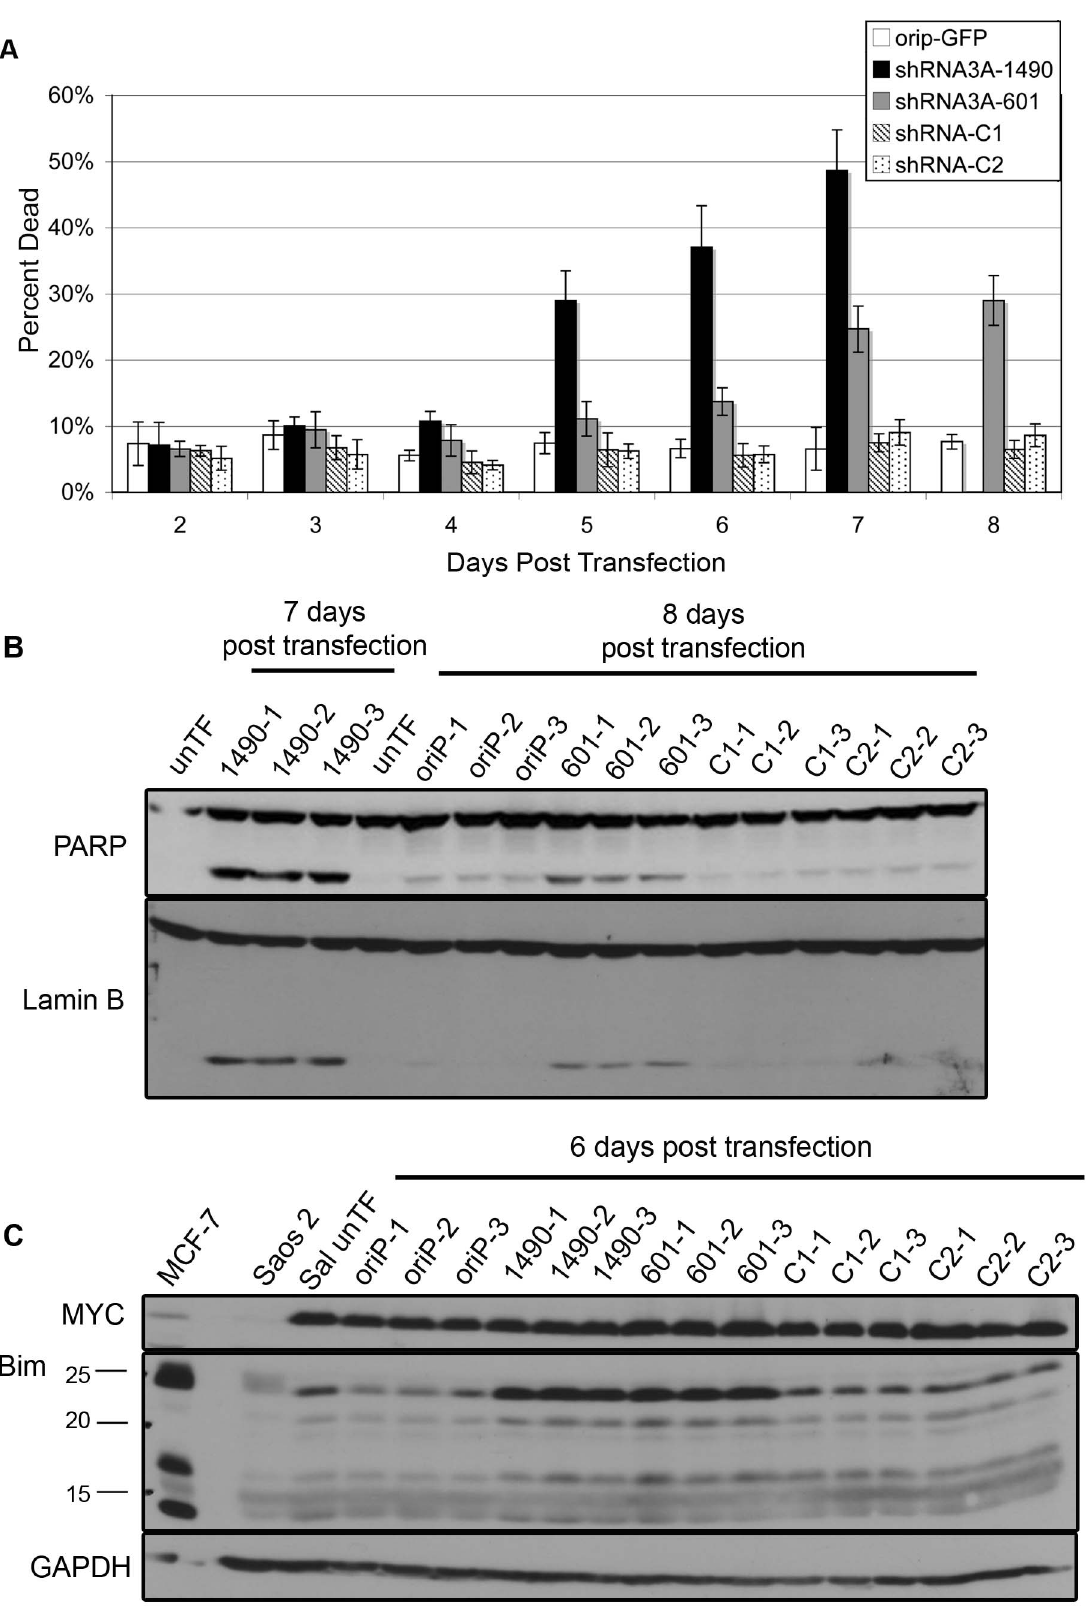
Figure 3. Reduced EBNA-3A expression is associated with increased expression of Bim and cell death. (A) The percentage of dead cells was measured following knockdown of EBNA-3A in two independent experiments performed in triplicate, and was determined to differ significantly between groups using Tukey’s test on pairwise comparison at each time point. The controls were combined as one group for analysis. Cells PLOS Pathogens |